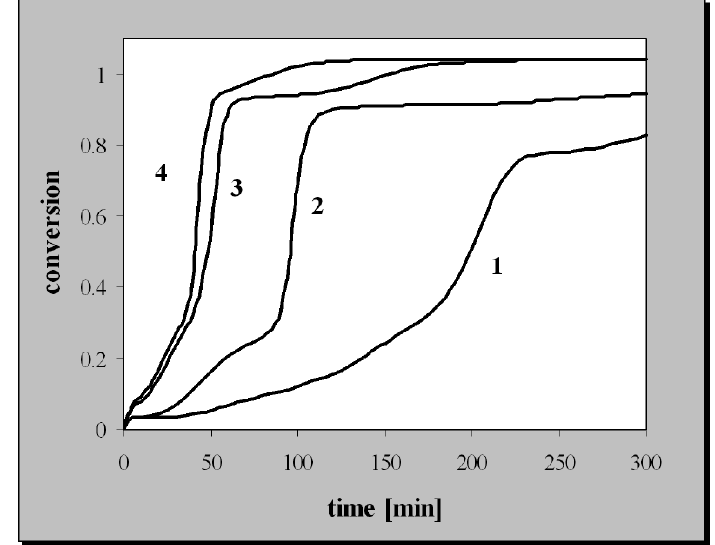
Fig. 6 Variation of monomer conversion with time for: (1) T = 50 o C and I 0 = 60 mol/m 3 ; (2) T = 60 o C and I 0 = 35 mol/m 3 ; (3) T = 70 o C and I 0 = 45 mol/m 3 ; (4) T = 80 o C and I 0 = 20 mol/m 3 { predictions of MLP (3:9:3:1) on testing data